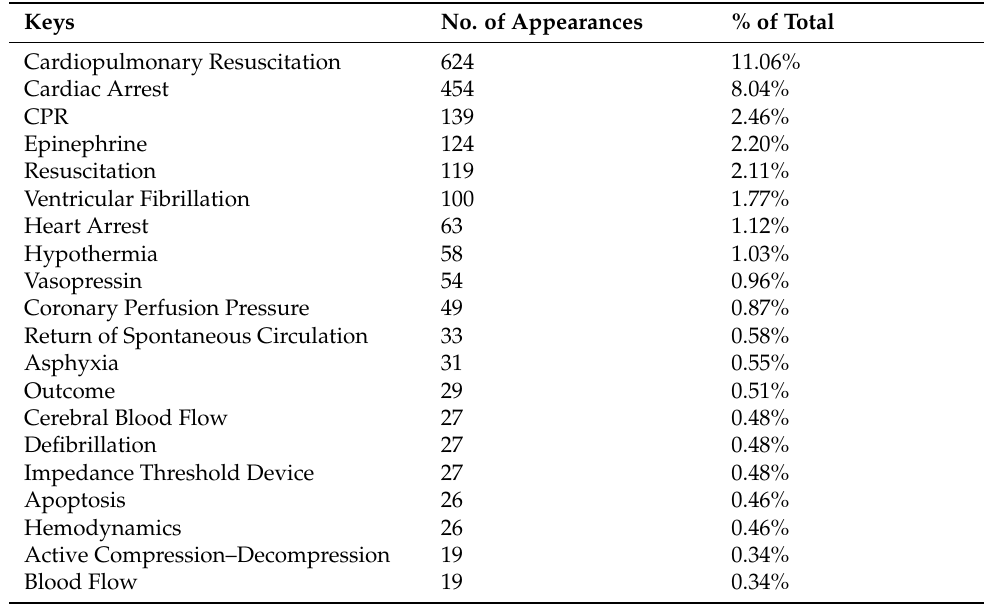
Table 1. Most important keywords in the CPR